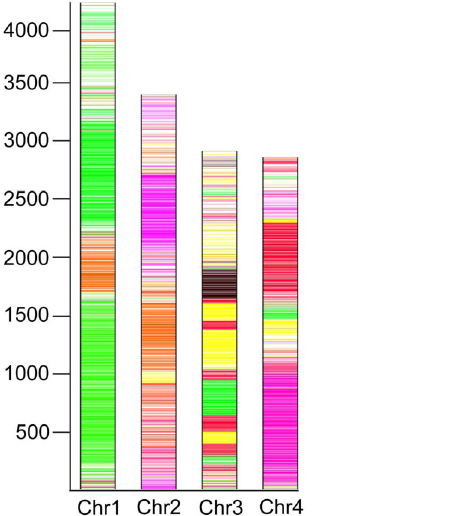
Figure 3. Shared gene homology map between Fa05001 and F. graminearum PH-1 has been created using the four defined F. graminearum chromosomes as templates. Genes in F. graminearum are coloured according to whether genes have corresponding orthologs in Fa05001, with one gene being one strip. Regions of the same color match to the same supercontigs (Figure S2 in File S1) in F. avenaceum . White regions represent lack of orthologs in Fa05001.